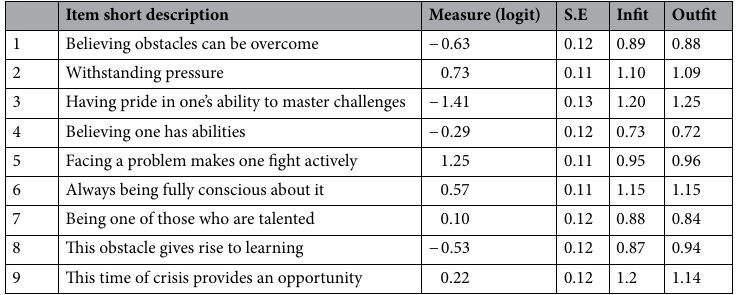
Table 6. Measure and fit statistics. S.E. = Standard error, infit = information-weighted fit statistics; outfit = outlier-sensitive fit